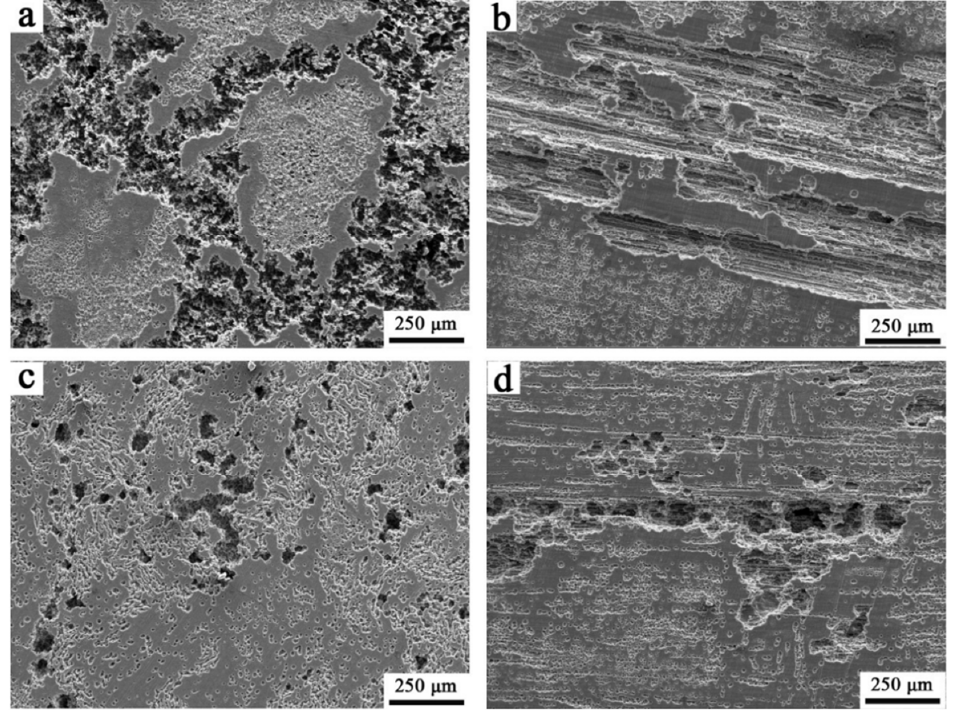
Figure 12. Corrosion morphologies of specimens after the immersion of 12 h, ( a ) transversal section and ( b ) longitudinal section of Ex-AZ91-free alloy; ( c ) transversal section and ( d ) longitudinal section of Ex-AZ91-Y alloy.